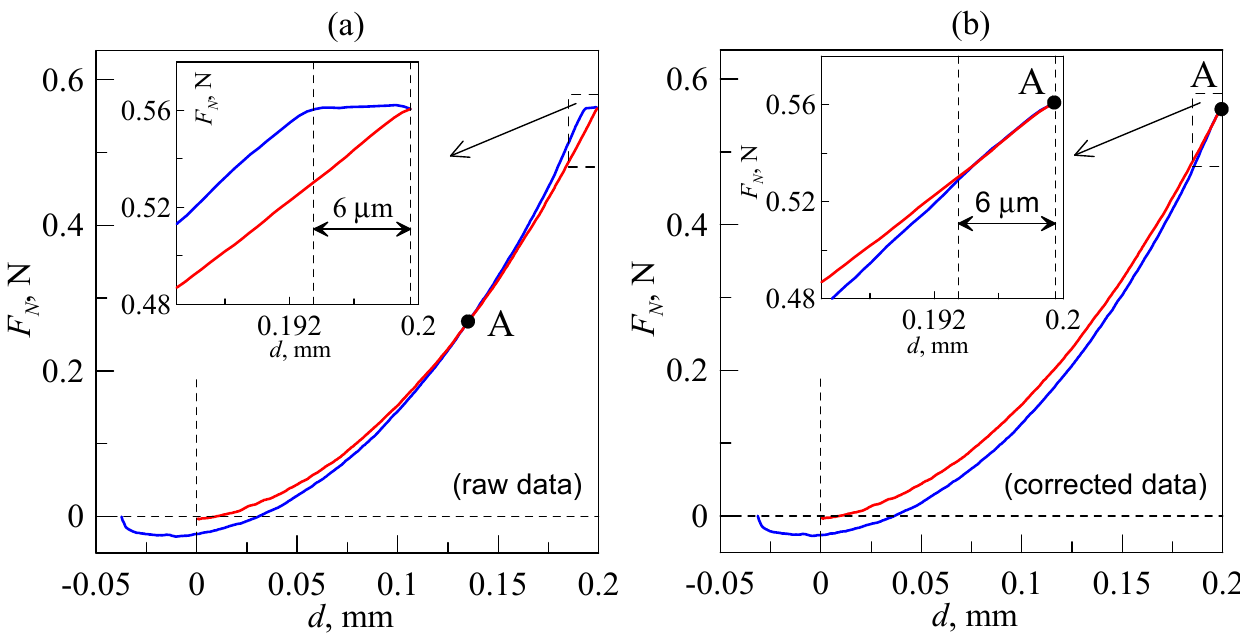
Figure 3. Dependencies of the normal force ( F N ) on indentation depth ( d ) measured during the indentation of the spherical indenter with a radius of R = 33 mm into a rubber ( TARNAC CRG N3005 ) substrate with a thickness of h = 5 mm [33]. Experiments were performed with the equipment shown in Figure 1. ( a ) Raw measured data; ( b ) dependencies with compensation for a backlash of the